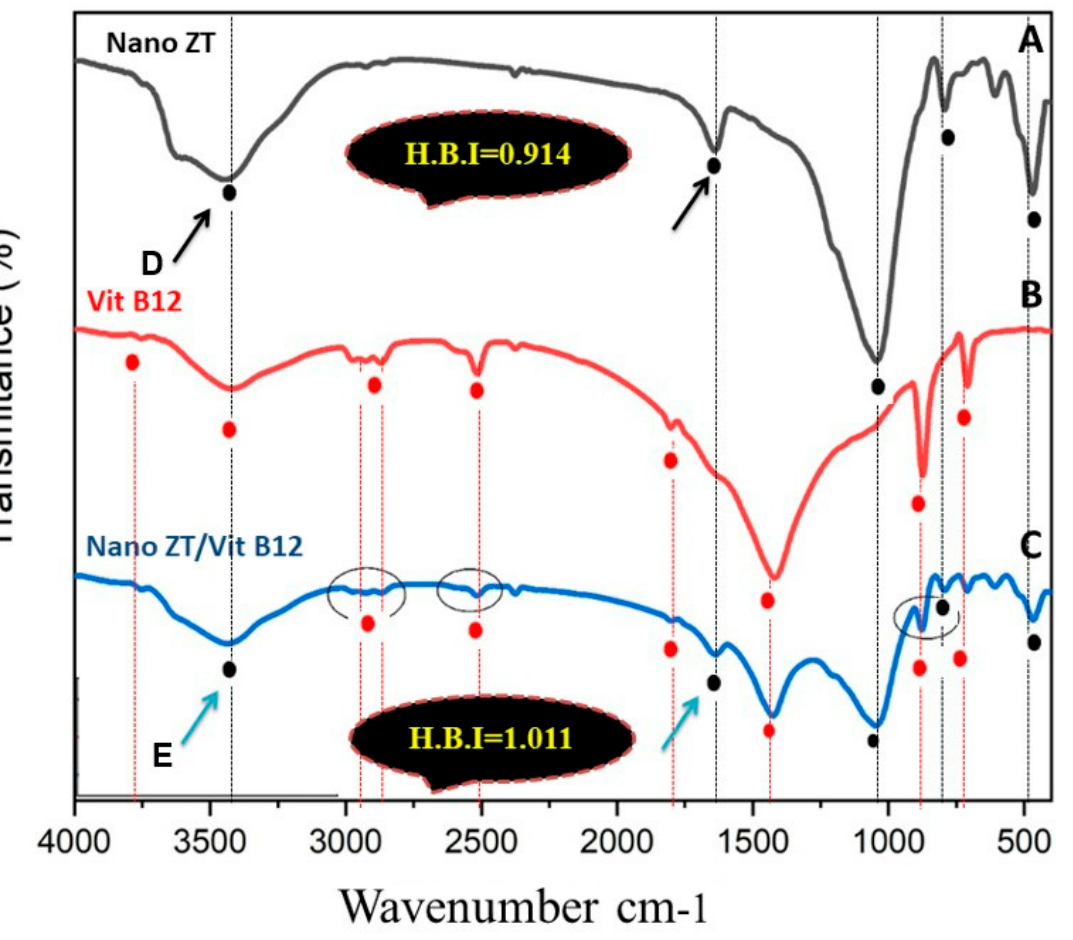
Figure 4. FTIR of the Nano ZT, VB12 and Nano ZT/Vit B12 ( A – C ); XRD pattern of Nano ZT ( D ) and Nano ZT/Vit B12 ( E ).